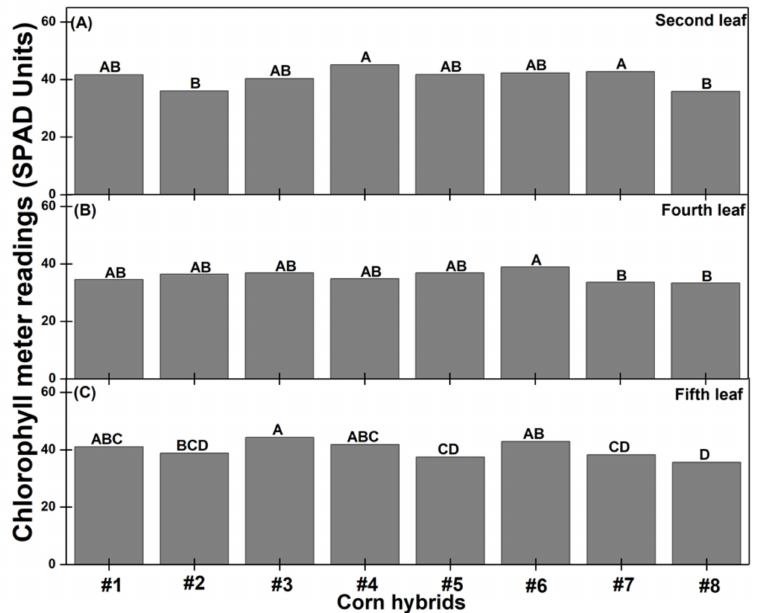
Figure 7. Chlorophyll meter readings on second ( A ), fourth ( B ), and fifth ( C ) leaves of corn plants among different hybrids. Same letters on bars indicate means do not differ significantly ( p < 0.10) based on Fisher’s least significant difference test. Data was averaged over waterlogging duration due to absence of significant interaction between waterlogging duration and hybrids as well as no significant effect of waterlogging